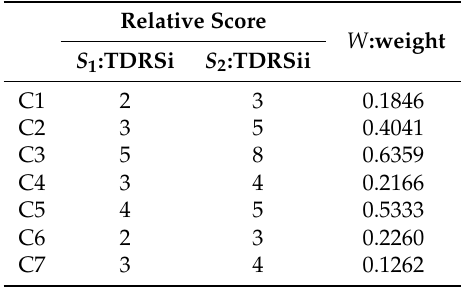
Table 5. The input parameter: score and